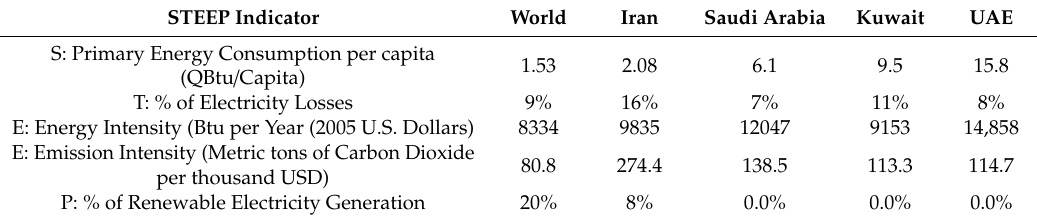
Table 5. STEEP comparison between Iran, Saudi Arabia, Kuwait, UAE and the world’s average between 1990 & 2010. Based on data from [60,61]. STEEP Indicator World Iran Saudi